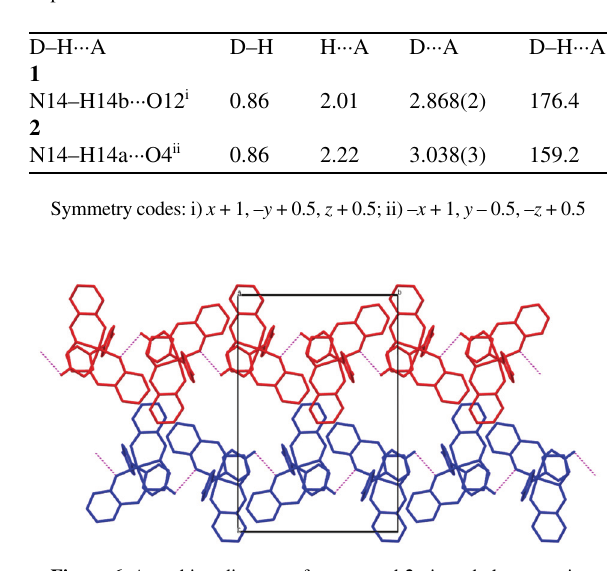
Table 4. Hydrogen-bond distances (Å) and angles (°) in com- pounds 1 and 2 .